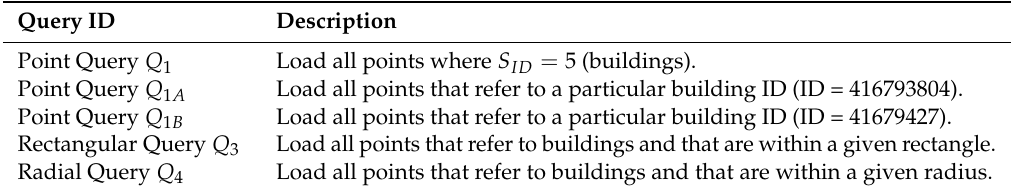
Table 2. The five different queries used for the SMALL dataset, which differ slightly from the ones used for the MEDIUM and LARGE datasets. Note that loading of points implies finding the correct set of points and loading them into memory.